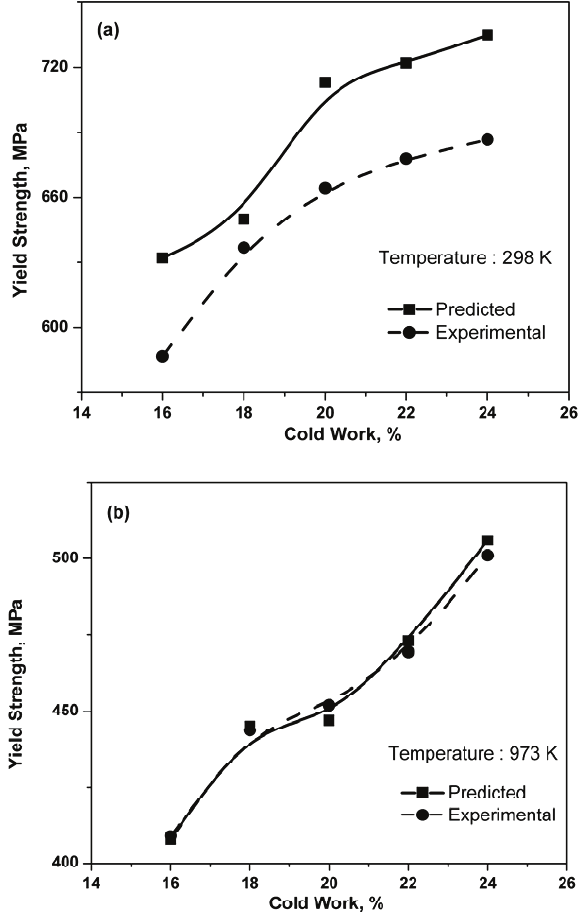
Figure 8. Comparison between the actual yield stress and the predicted yield stress by Voce equation at (a) 298 K (b) 973